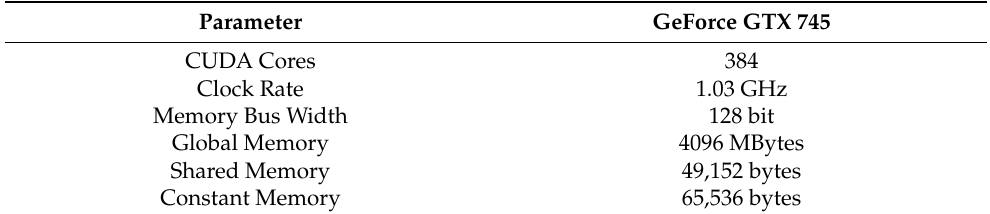
Table 1. Hardware parameters of the NVIDIA